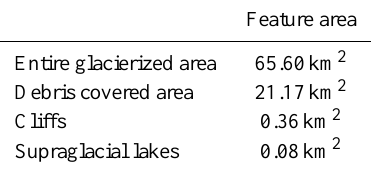
Table 2. Horizontally projected area of the melt-relevant surface types on Koxkar Glacier derived from satellite imagery